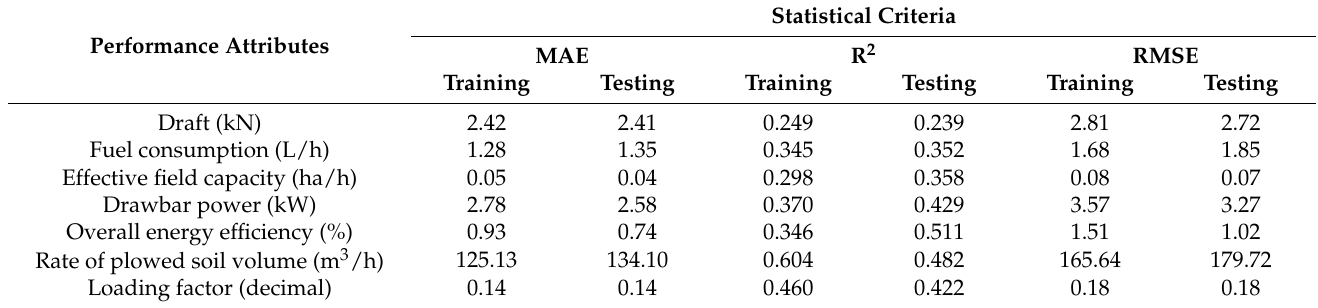
Table 5. Statistical criteria of the established MLR models for prediction of the performance attributes for tractor-chisel unit during soil-tillage process in the case of the testing and training